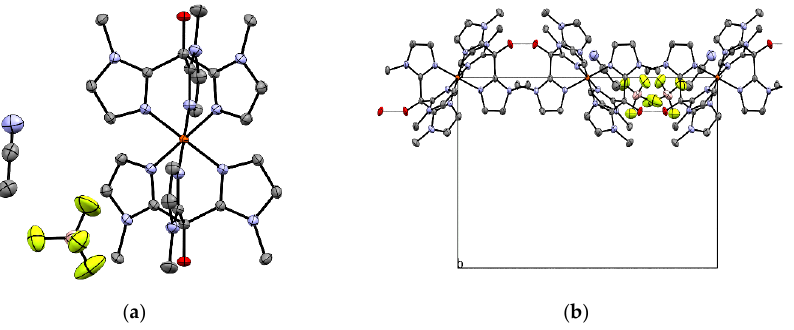
Figure 2. ( a ) Molecular structure of [Fe((mim) 3 COH) 2 ](BF 4 ) 2 ∙MeCN ( 1 ). ( b ) Zig-zag chains of 1 parallel to the z -axis, stabilized through intramolecular hydrogen bonds between the ligands’ OH-groups.